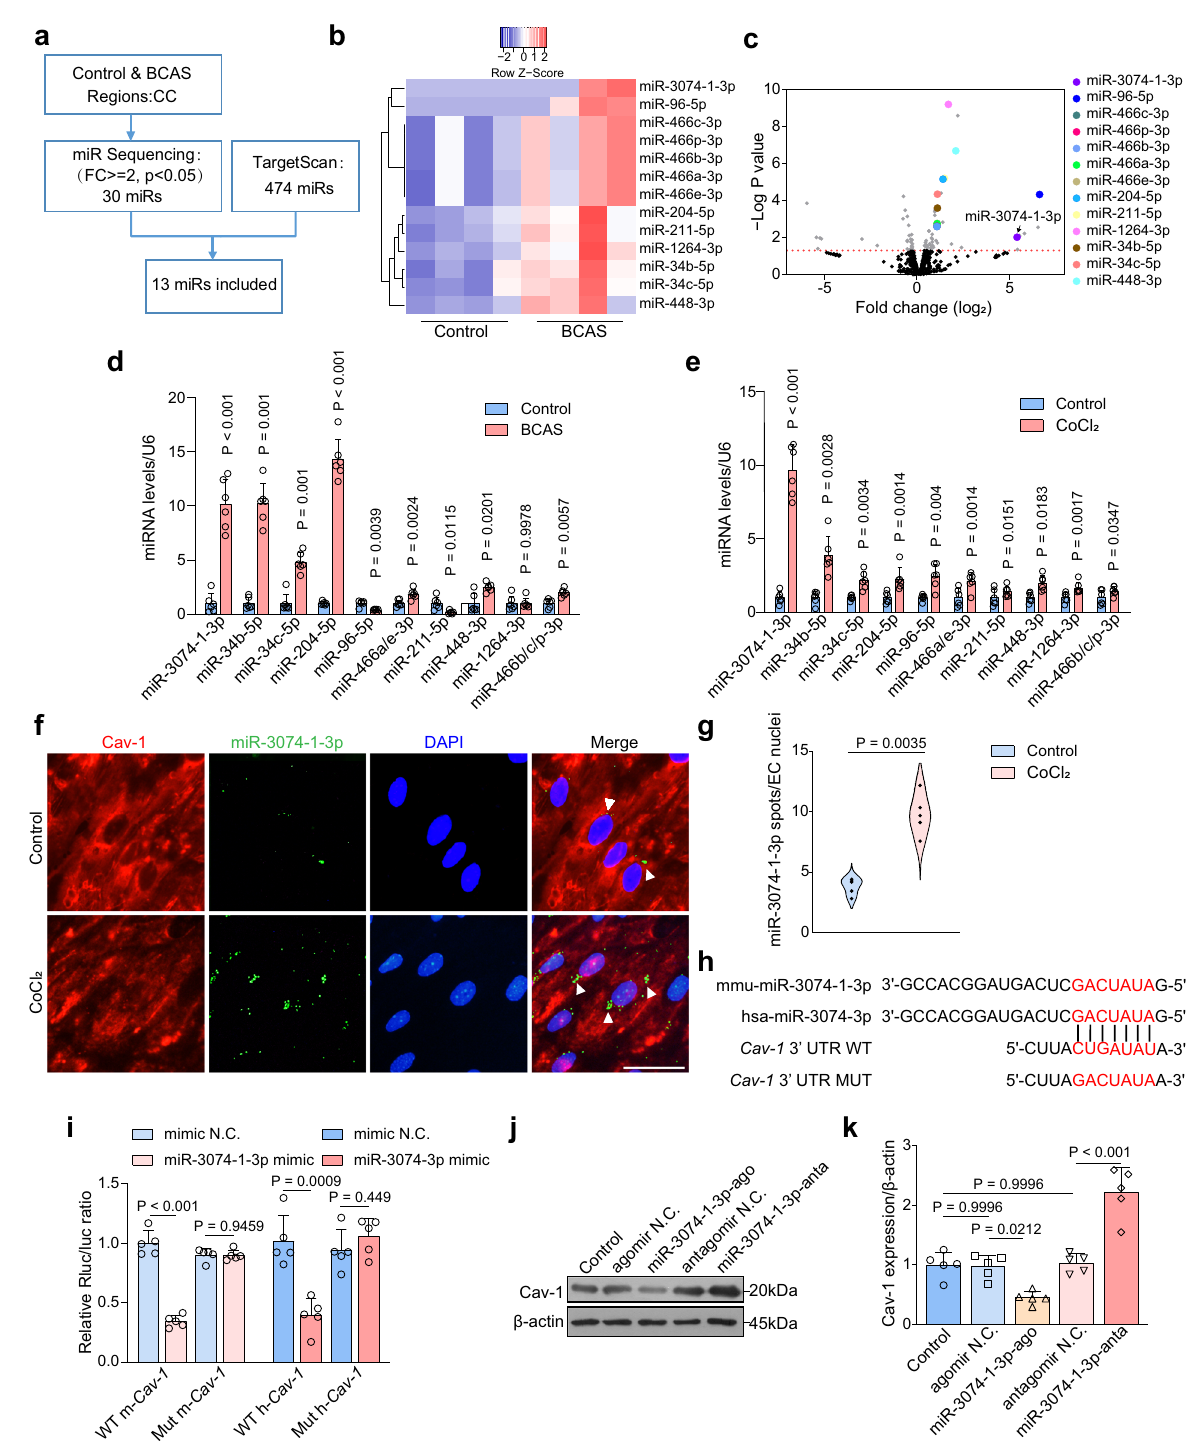
Fig. 6 | Endothelial miR-3074-1-3p targeting Cav-1 is upregulated after BCAS. a – c Systematic screening of upregulated miRNAs targeting Cav-1 after 4 weeks of BCAS ( n =4 mice/group). d , e Veri fi cation of 13 miRNAs in the CC of BCAS mice ( n =6 mice/group) and BMECs under chronic hypoxia ( n =6 independent primary cellcultures/group). f , g CombinedFISHandimmuno fl uorescencelabelingofmiR- 3074-1-3p and Cav-1 in BMECs of control and CoCl 2 groups ( n =5 independent primarycellcultures/group).Scalebar,50 μ m. h , i Dualluciferasereporterassayof the interaction of miR-3074-(1)-3p mimic and wild type mouse/human Cav-1 ( n =5